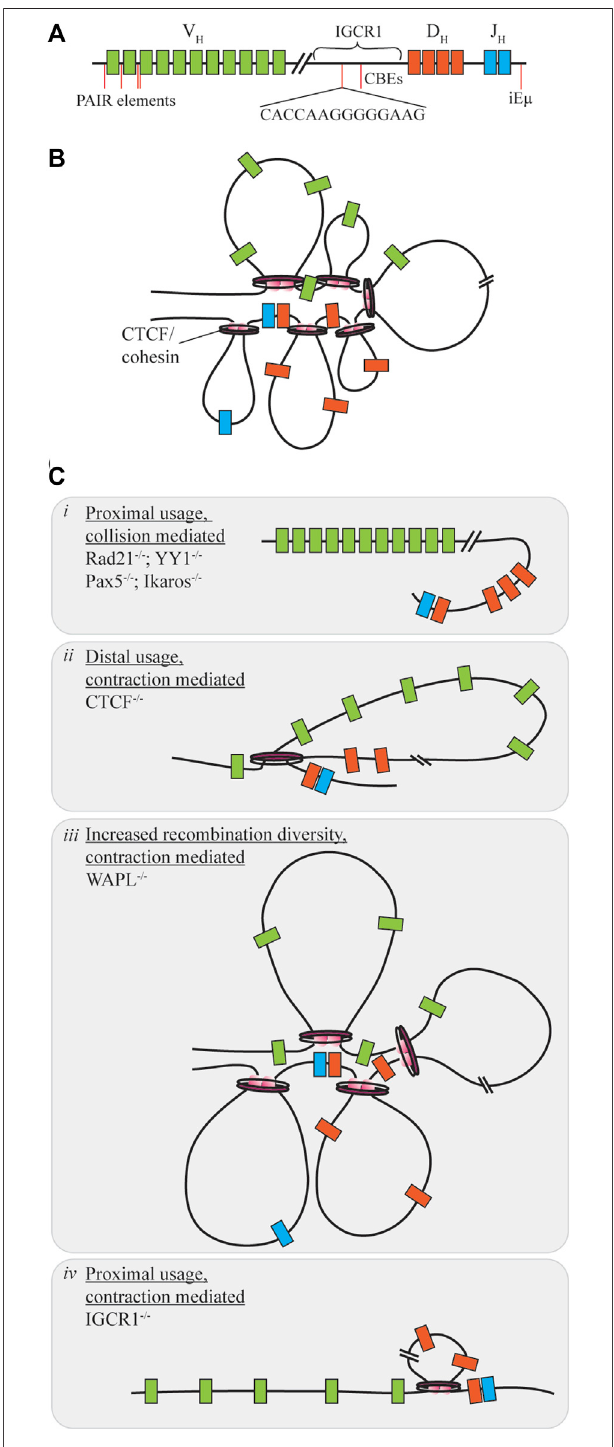
FIGURE 3 | Contraction mediated conformational changes of the Ig locus. (A) TheIgHlocuscontainsV,D,andJsegmentsspreadover2.8 MBof the chromosome, with regulatory regions distrubuted throughout the locus. (B) Under normal conditions contraction of the locus allows for gene